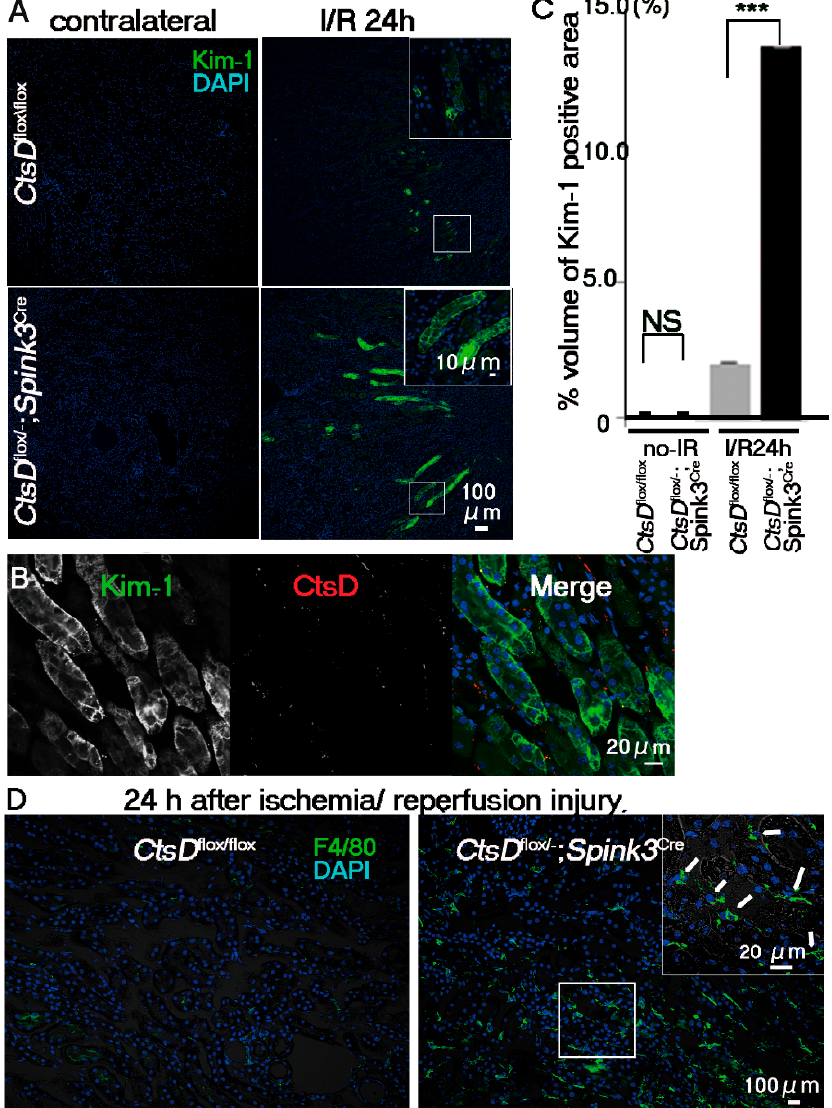
Figure 4. CtsD -deficiency caused severe damage in renal proximal tubular epithelial cells following ischemia/reperfusion injury. ( A ) Immunostaining of Kim-1, a marker of early acute injury of renal tubular cells (green) with DAPI (blue) in renal tissues obtained from CtsD flox/flox and CtsD flox/ − ; Spink3 Cre mice at 24 h after ischemia/reperfusion injury (I/R 24 h). As control sample, the cortico-medullary region of the contralateral kidney was employed (contralateral). Scale bars indicate 100 µ m ( B ) Representative image of Kim-1 (green) and cathepsin D (CtsD; red) immunostaining in CtsD f/ − ; Spink3 Cre mouse kidney, 24 h after ischemia/reperfusion injury. DAPI (blue) ( C ) Quantification of Kim-1-positive areas of the cortico-medullary region of CtsD flox/flox and CtsD flox/ − ; Spink3 Cre mice kidneys. The volume density of Kim-1-positive renal proximal tubular epithelial cells in total renal tissues obtained from CtsD flox/ − ; Spink3 Cre (black, CtsD flox/ − ; Spink3 Cre I/R 24 h; 13.7 ± 7 × 10 − 5 %) and CtsD flox/flox ( CtsD flox/flox I/R24h; 2.12 ± 2 × 10 − 5 %) mice at 24 h following ischemia/reperfusion injury. n = 3, *** p < 0.001. In kidneys without I/R injury, there was little difference between CtsD flox/flox ( CtsD flox/flox no-I/R; 0.02 ± 5 × 10 − 7 %) and CtsD flox/ − ; Spink3 Cre mice ( CtsD flox/ − ; Spink3 Cre no-I/R; 0.04 ± 9 × 10 − 7 %). n = 3 ( D ) Representative image of kidney sections immunostained with F4/80, a marker for macrophage (green) and DAPI (blue), at 24 h after renal ischemia reperfusion injury. Signals of F4/80 increased in CtsD flox/ − ; Spink3 Cre kidney (white arrows). Scale bars indicate 100 µ m and 20 µ m in